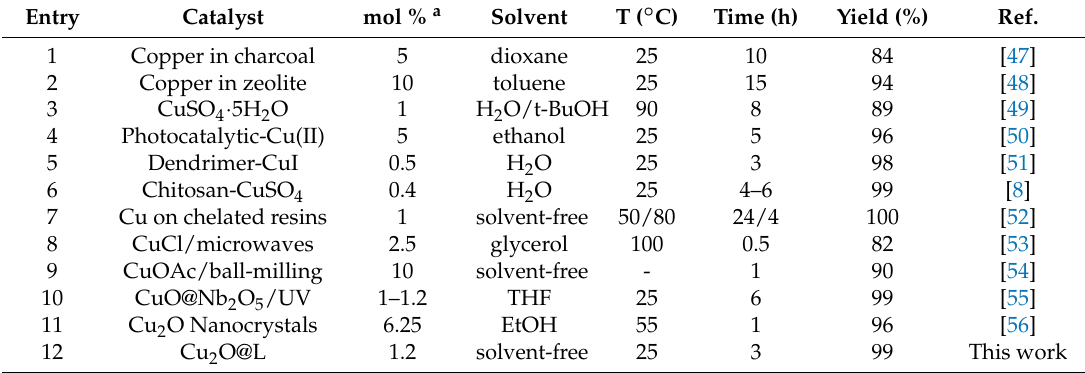
Table 2. The brief comparison of this catalyst with previous ones for Huisgen “click” reactions of azides and alkynes.